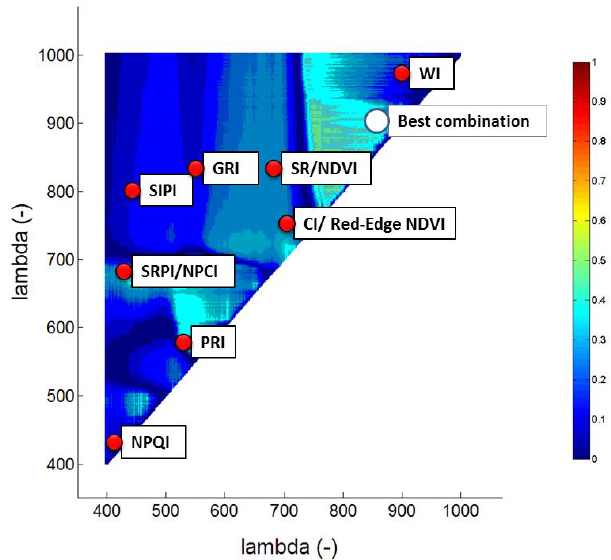
Figure 1. A selected example of a correlogram between NSD-type indices and midday average GPP for all sites pooled. The correl- ogram shows all R 2 values, the white dot indicates the two-band combination with the highest R 2 value and the red dots indicate the location of the reference VIs reported in Table 2 (SR: sim- ple ratio; GRI: green ratio index; WI: water index; SRPI: simple ratio pigment index; NDVI: normalized difference vegetation in- dex; NPQI: normalized phaeophytinization index; NPCI: normal- ized pigment chlorophyll index; CI: chlorophyll index; red-edge NDVI; SIPI: structural independent pigment index; PRI: photo- chemical reflectance